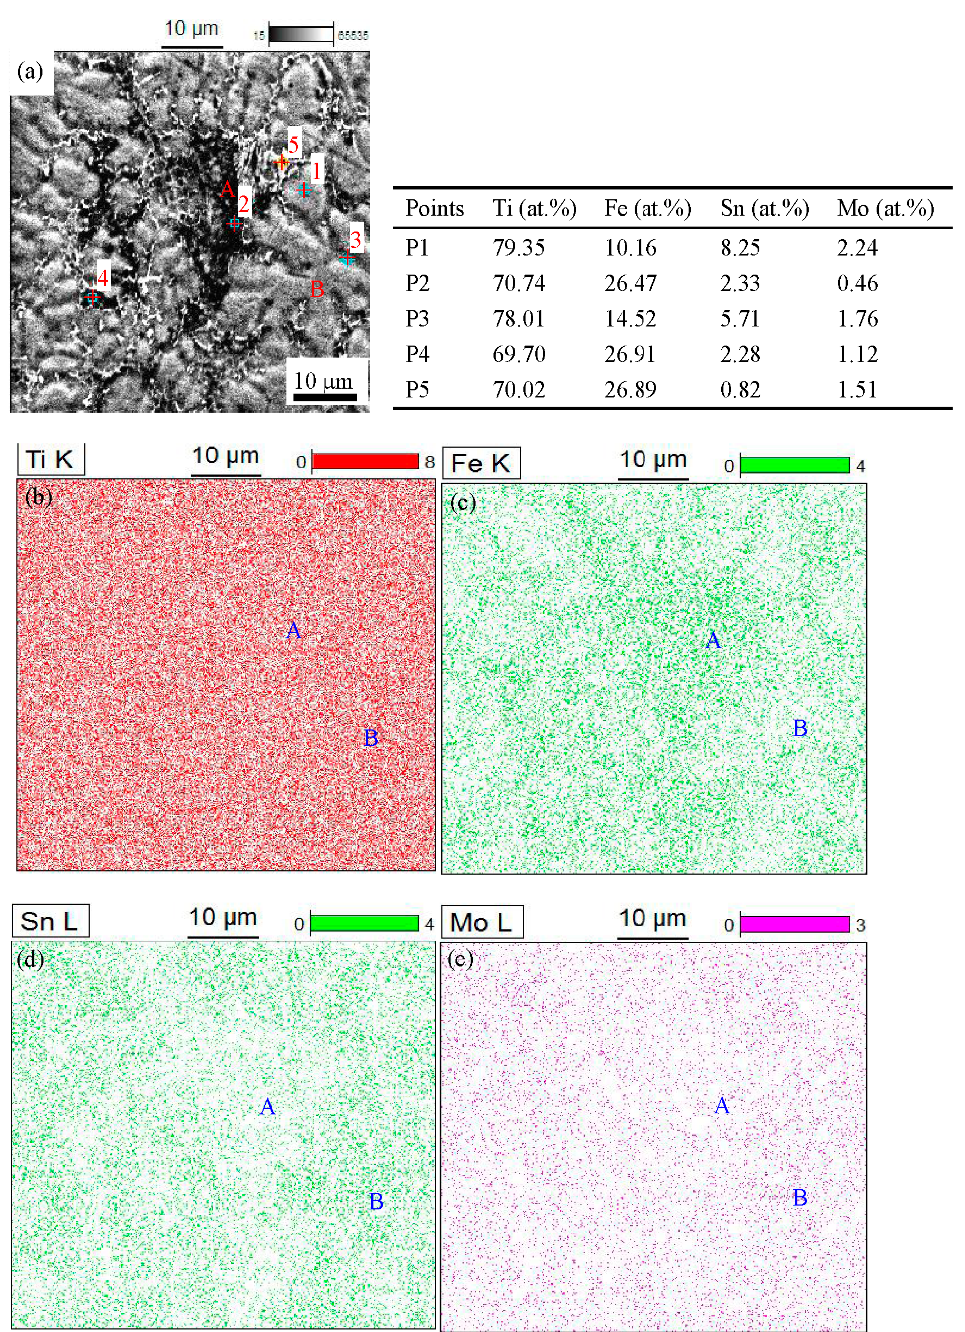
Figure 3. Energy dispersive spectrometer (EDS) pictures of Ti 75 Fe 19 Sn 5 Mo 1 alloy. ( a ) Scanning electron microscopy (SEM) picture and element content at each point scanning; ( b–e ) surface distribution of elements at place